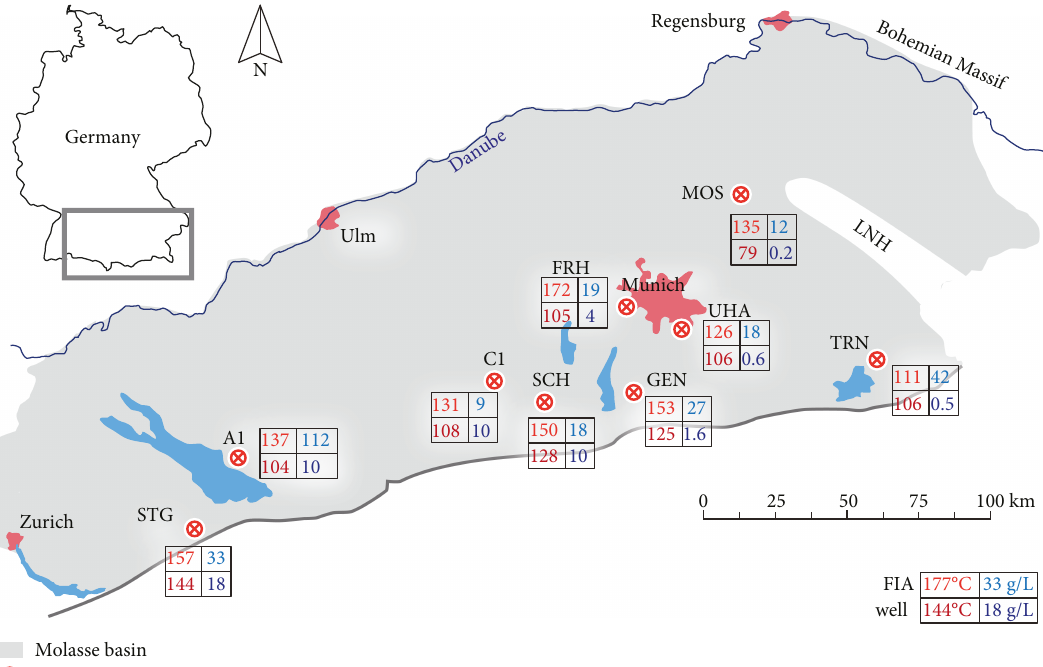
Figure 15: Overview of the study area in the Molasse Basin, southern Germany and eastern Switzerland. In addition, the measured temperature and salinity values measured in the fl uid inclusion assemblage (FIA) of the cement phase of the late vein calcites and in the present reservoir fl uid are